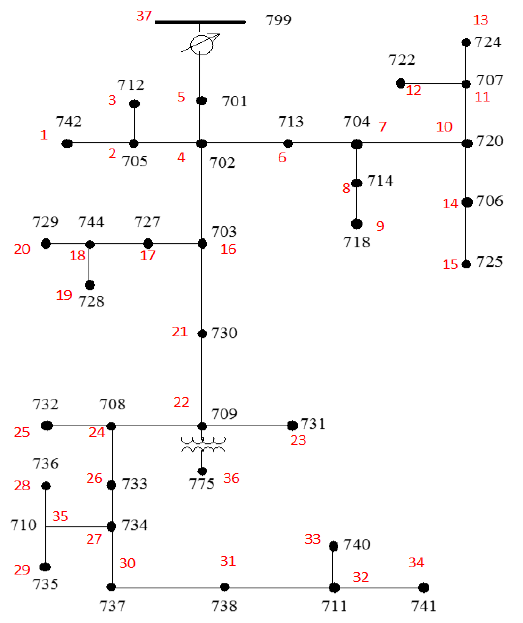
Figure 7. IEEE 37-node test feeder.